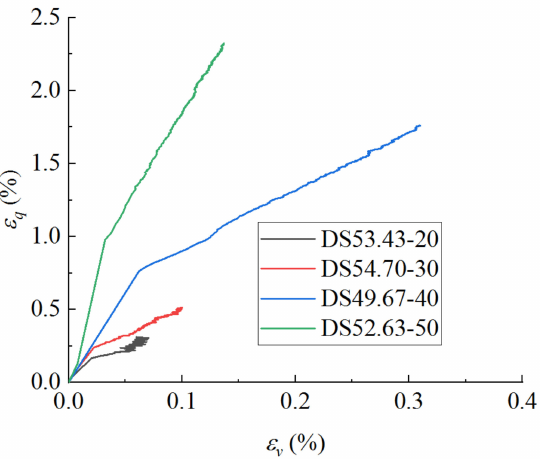
Figure 4. Relationship between the accumulated deviatoric strain and accumulated volume